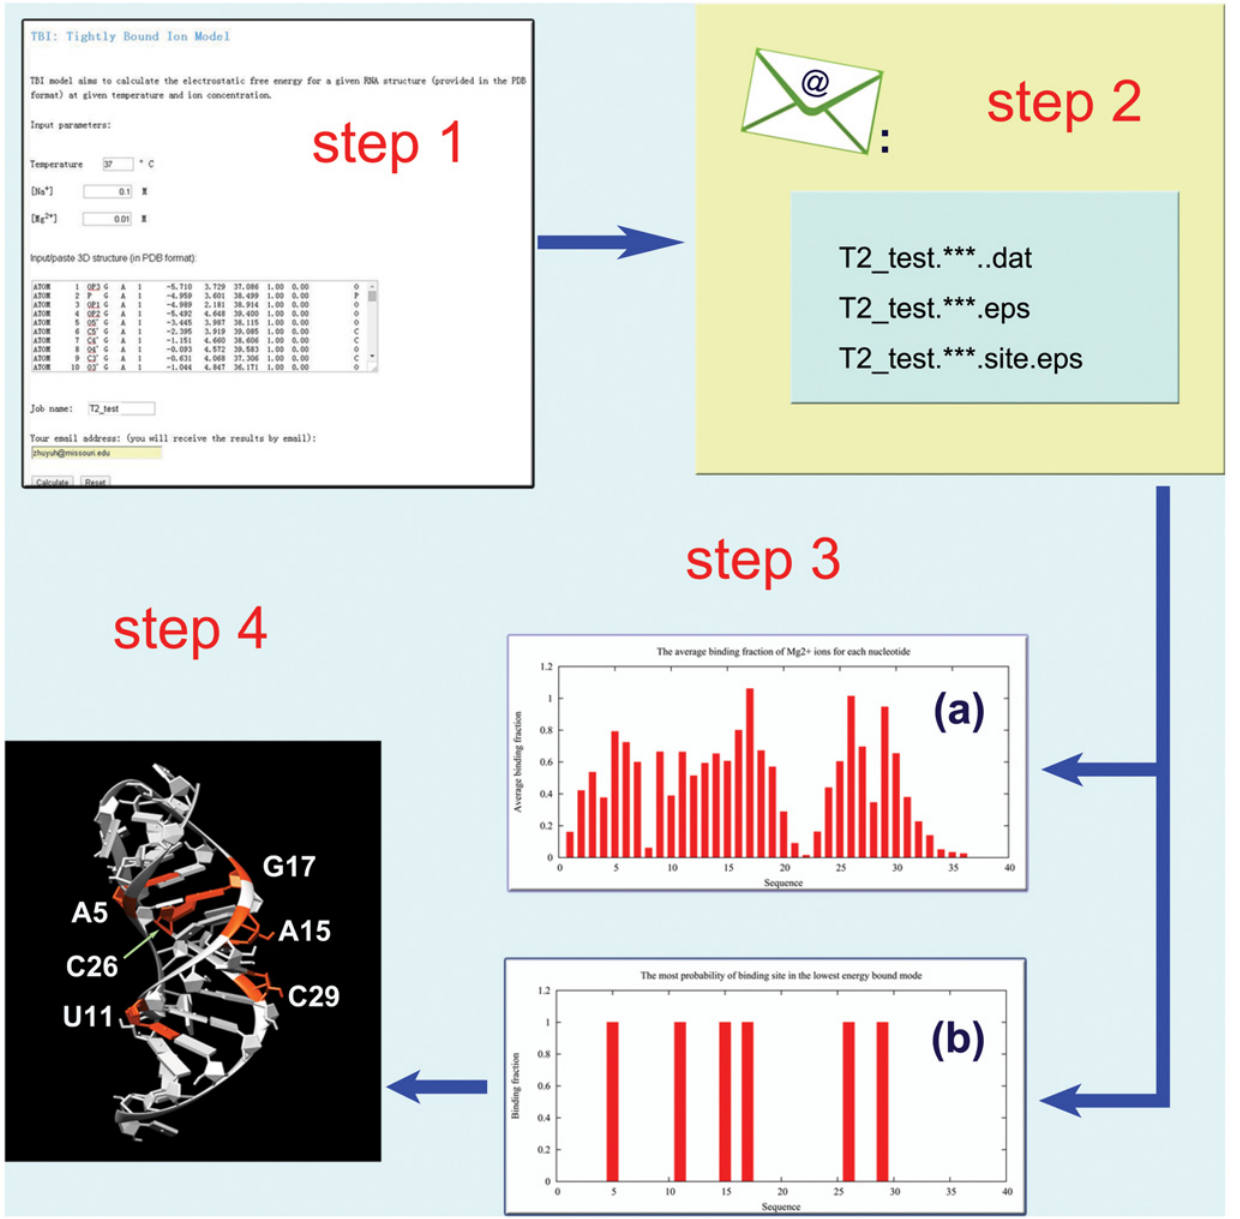
Fig 5. An example for the usage of the TBI server. The server computes the ion binding properties and the electrostatic free energies for T2 RNA (PDB code 2TPK [25]) in a solution with 10 mM Mg 2+ , 100 mM Na + , and T =